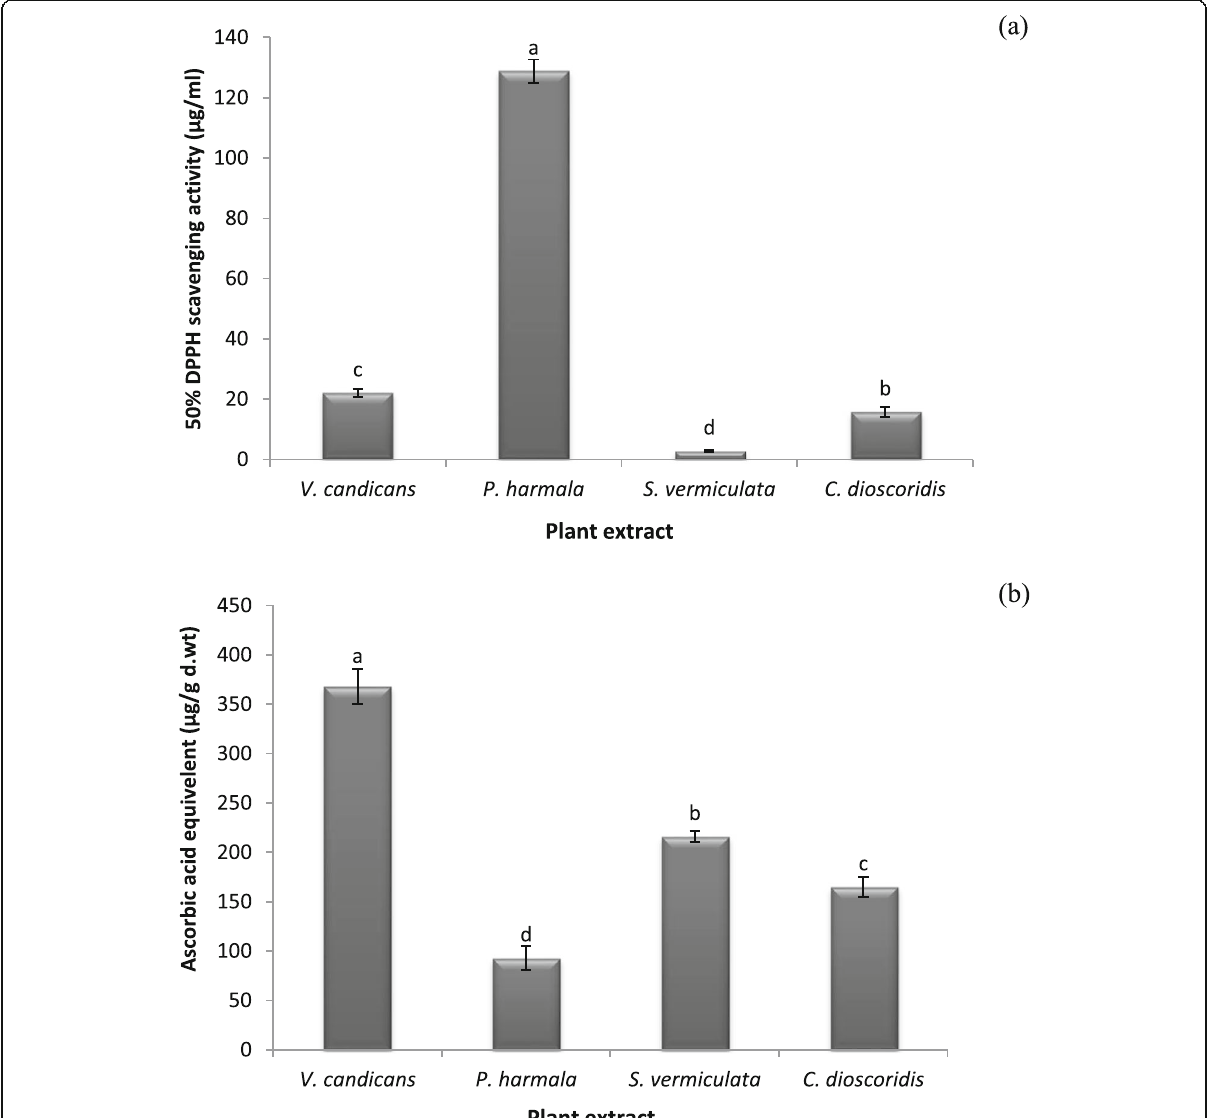
Fig. 1 Free radical scavenging activity (IC 50 value) ( a ) and the total antioxidant capacity ( b ) of the ethanolic extract of four Egyptian wild plant species. Values having different superscripts are statistically significant at P < belonging to different chemical classes (Table 5). The most prominent compounds are represented in hexadeca- trienoic acid, methyl ester (63.13%), Cis-9-octadecenoic acid (11.43%), and 6-ethoxyquinaldine (6.00%). Moreover, other phytochemical constituents were identified in the ethanolic extract of P. harmala belonging to quinolines (5-Cyano-1,2,3,4-tetrahydro-2-methylisoquinoline and 4- Acetamido-1,2,3,4-tetra hydroisoquinoline), carotenoids (rhodopin), corticosteroids (betamethasone valerate), fatty acids (hexadecanoic acid, ethyl ester, 8,11-octadecadienoic acid, methyl ester, 2,5-octadecadienoic acid, methyl ester, 6-octadecenoic acid, (Z)-, 5,8,11,14,17-eicosapentaenoic acid, methyl ester and 4,7,10,13,16,19-docosahexaenoic